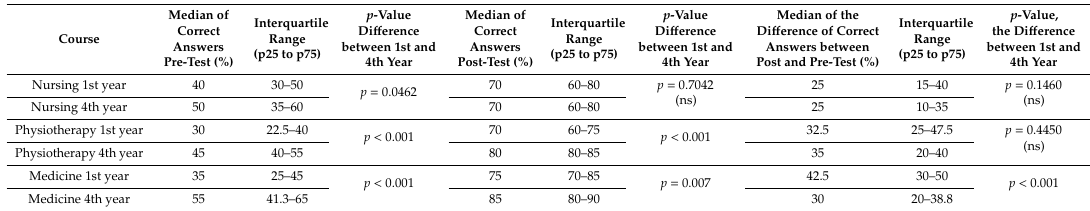
Table 3. Percentage of correct answers in the pre-tests and post-tests and di ff erence in right answers between them by course and